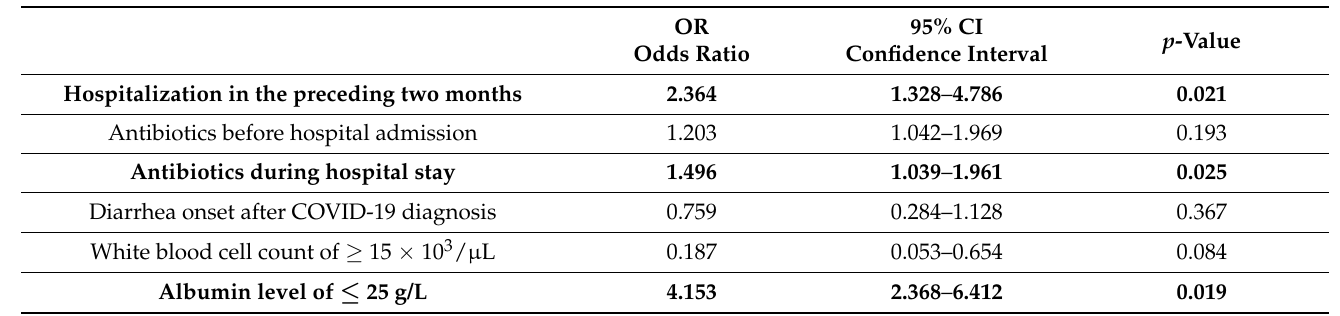
Table 2. Predictive factors associated with CDI occurrence during COVID-19 infection (multivariate